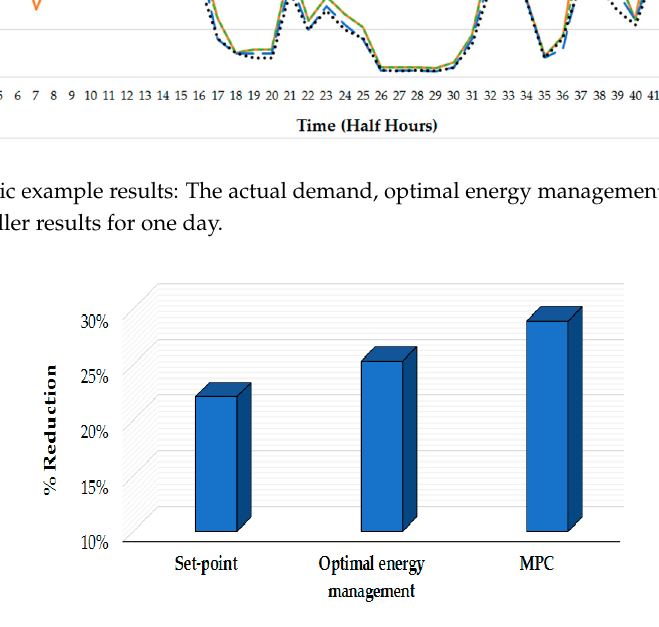
Figure 12. The percentage of demand reduction results for a specific case study.